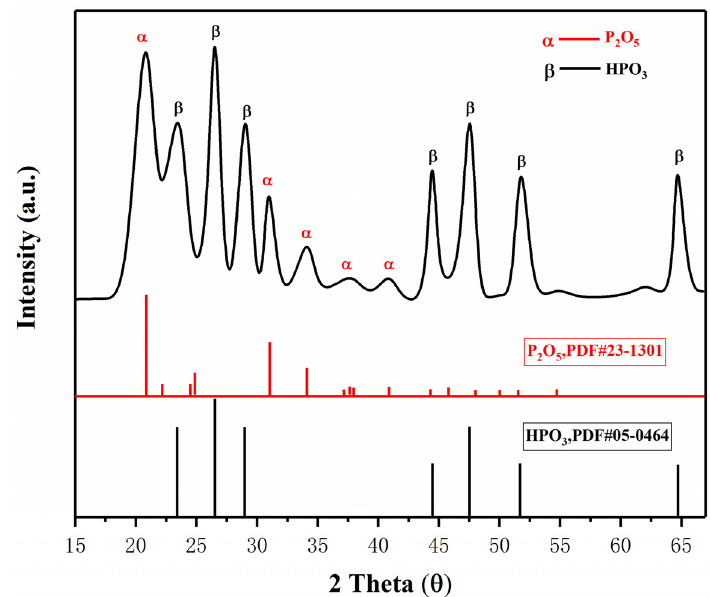
Figure 10. XRD analysis of pyrolysis products of NH 4 H 2 PO 4 .